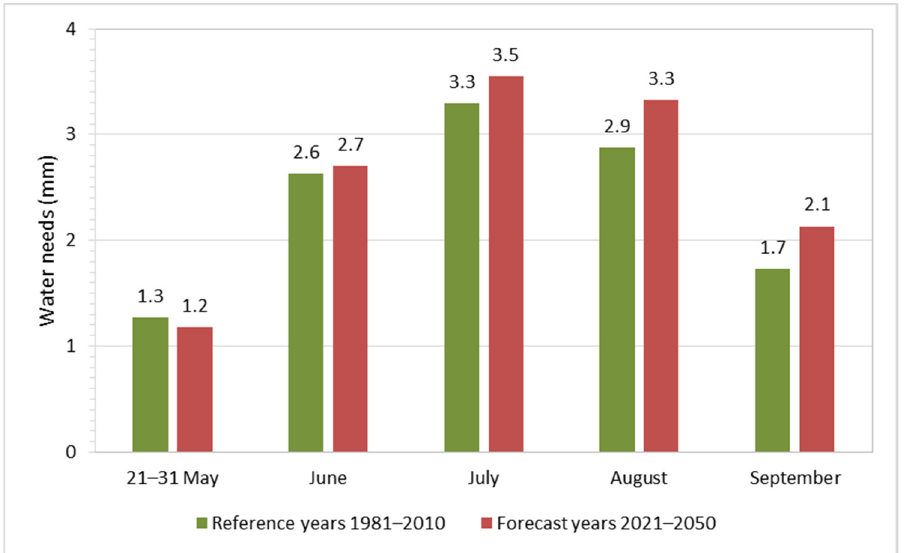
Figure 2. Mean daily water needs of giant miscanthus in the intensive growth season in the reference